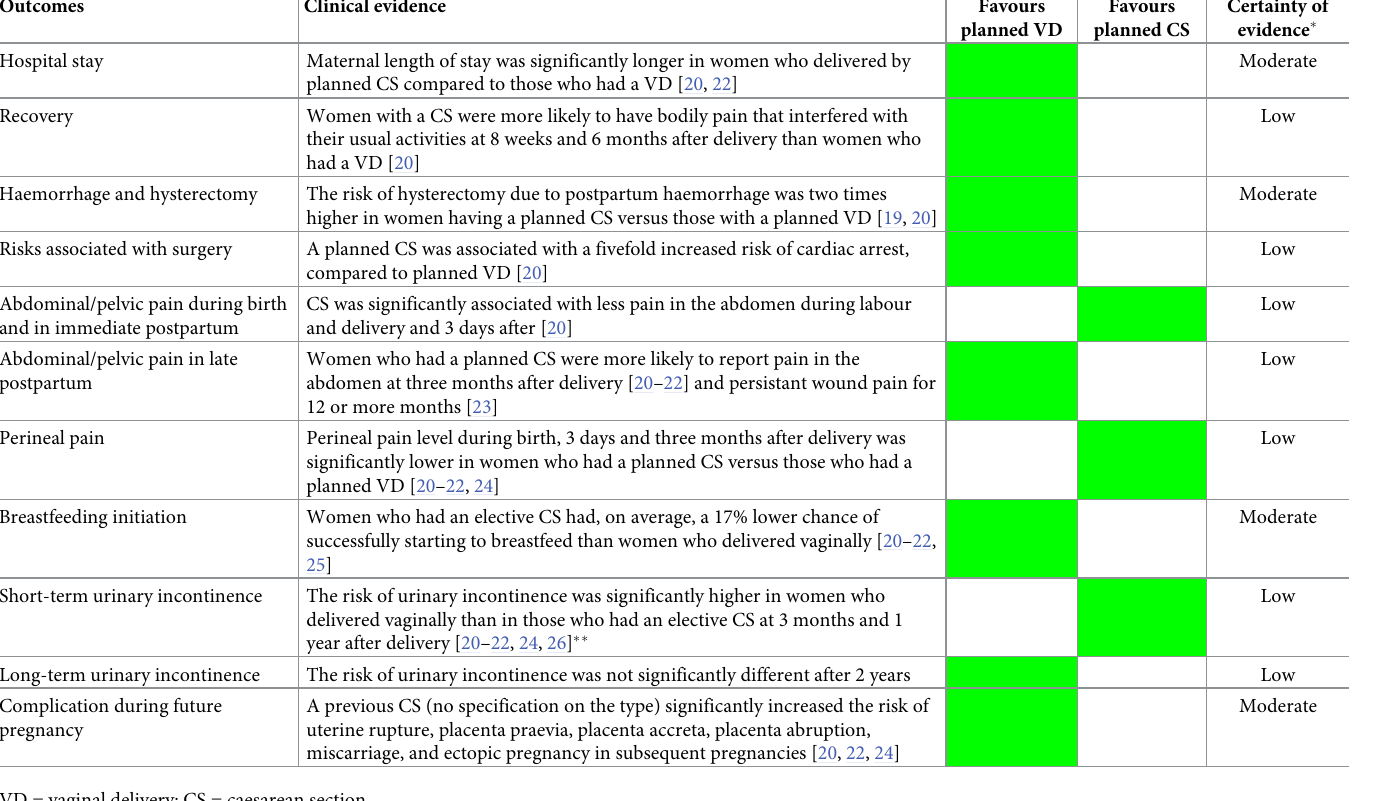
Table 3. Summary of maternal outcomes and certainty of evidence.